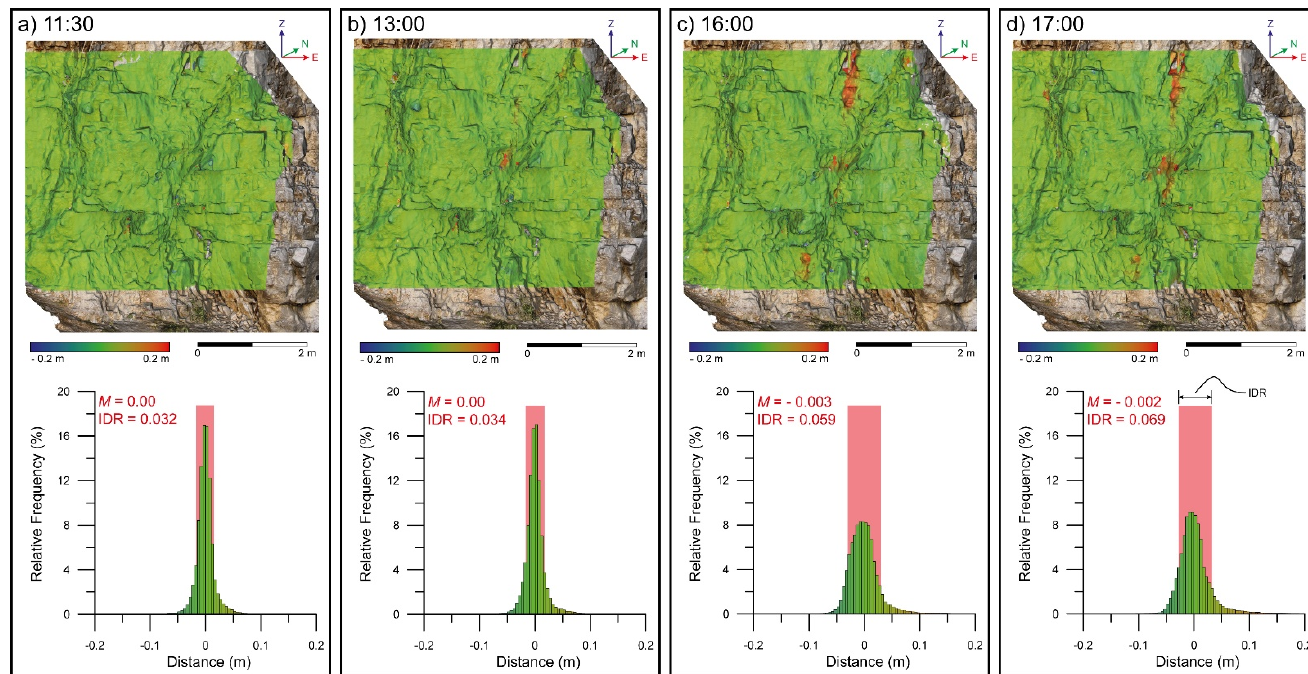
Figure 6. Color scale maps of residual distances between TIR point clouds, acquired at ( a ) 11:30, ( b ) 13:00, ( c ) 16:00 and ( d ) 17:00 during the spring survey, and the reference high-resolution RGB optical point cloud. For each map, the distribution of residual distances is plotted along with their statistical descriptors (M = median value and IDR = interdecile range).